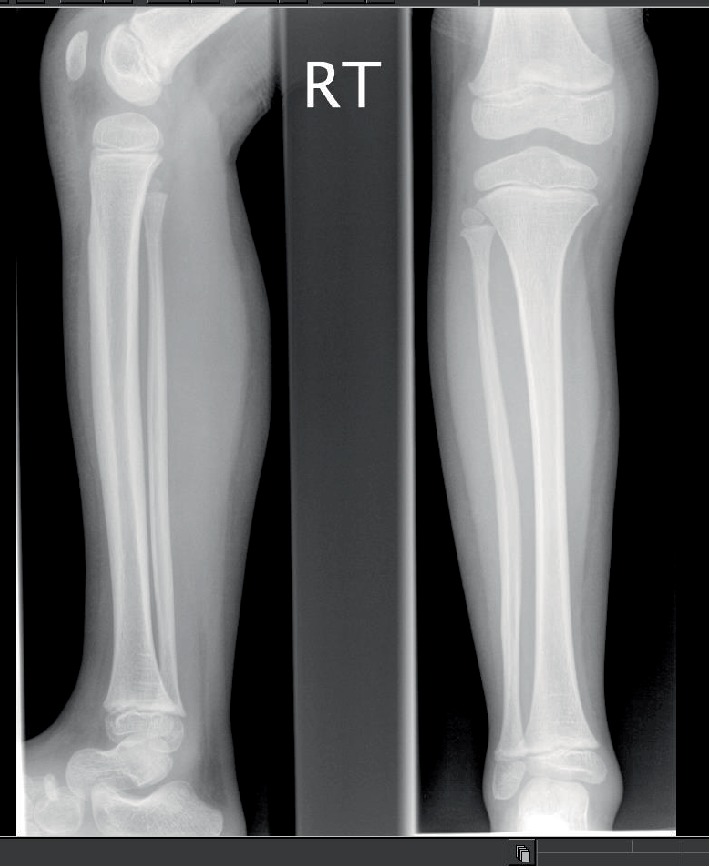
B1 radiograph of right lower limb (lateral and AP) aged 5 years.